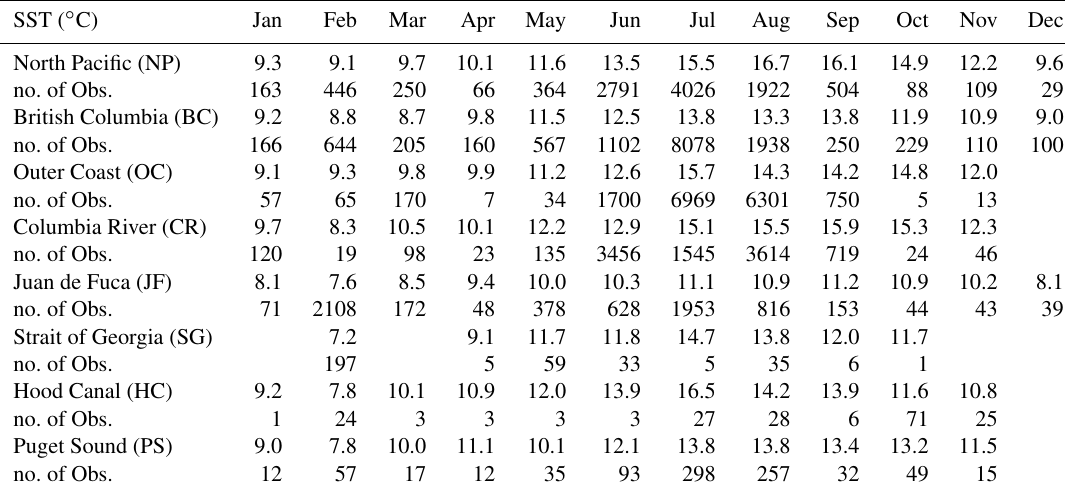
Table B2. Average monthly SST seasonal cycles for the eight unique regions. The total number of observations (no. of Obs.) contributing to the monthly average estimate is